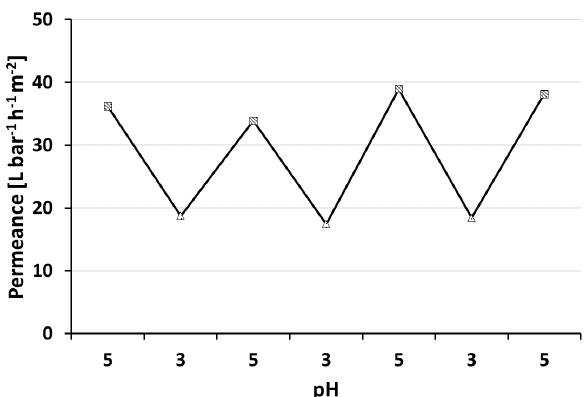
Figure 7. pH-responsive behaviour of a thin PS 83 - b -P4VP 17 _DOX 1001 _15s. BCP membrane on a PAN support with four test cycles at pH = 3 (triangle) and pH = 5 (square) respectively. The transmembrane pressure was set to 2 bar at room temperature.